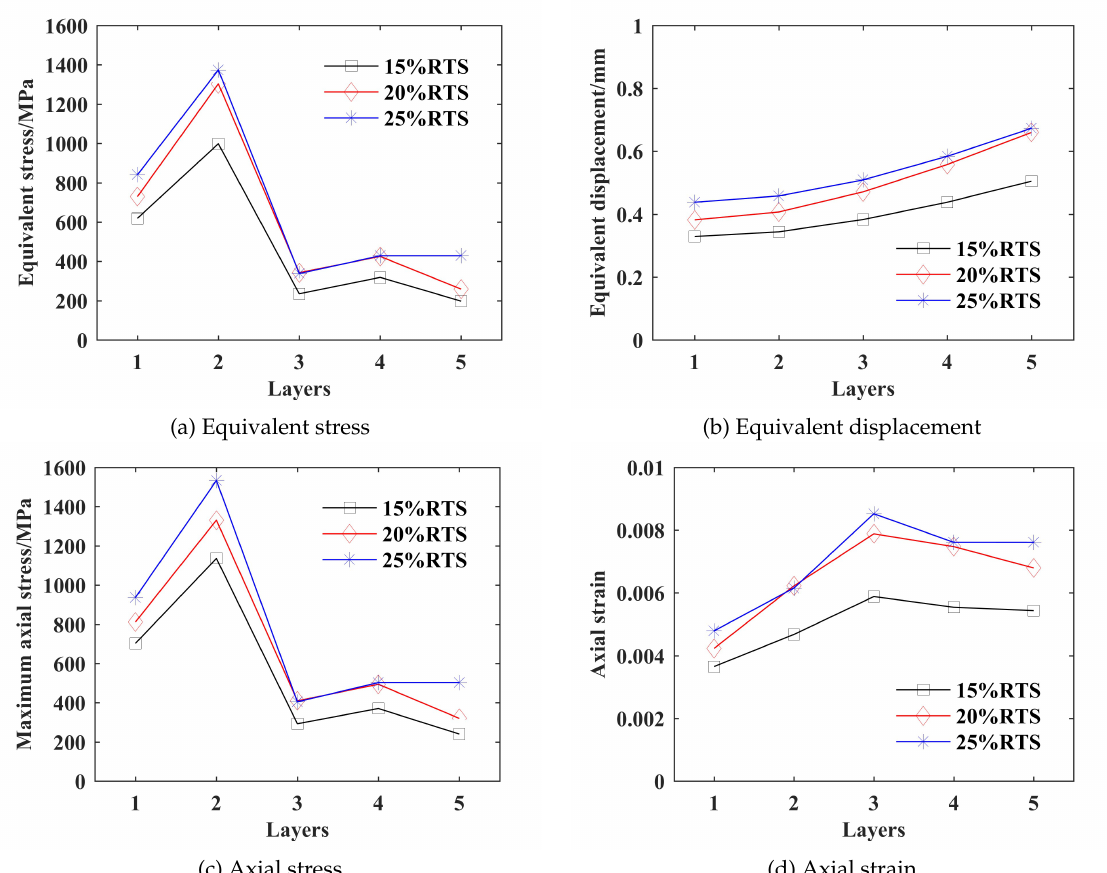
Fig. 9. Variation of state parameters of the positive feeder under different tensile loads